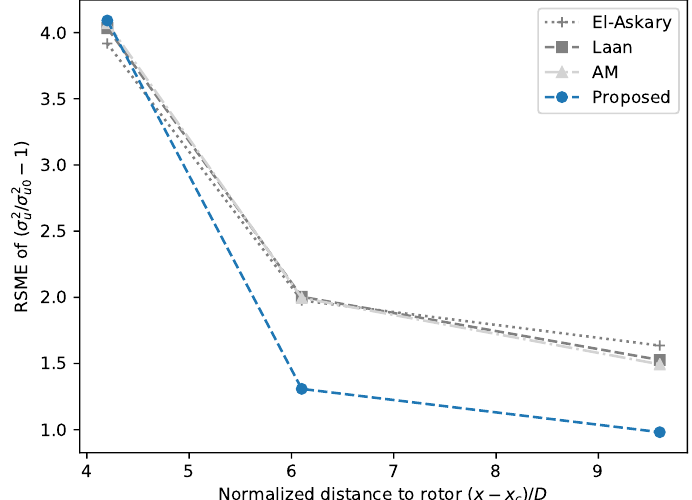
Figure 20. RSME of the lateral added turbulence in wakes of Danwin 180 kW wind turbines under the stable condition at hub height; σ u and σ u 0 represent the standard derivations of wind speed in wakes and in the atmosphere, respectively. All turbulence models are combined with AD based on thrust